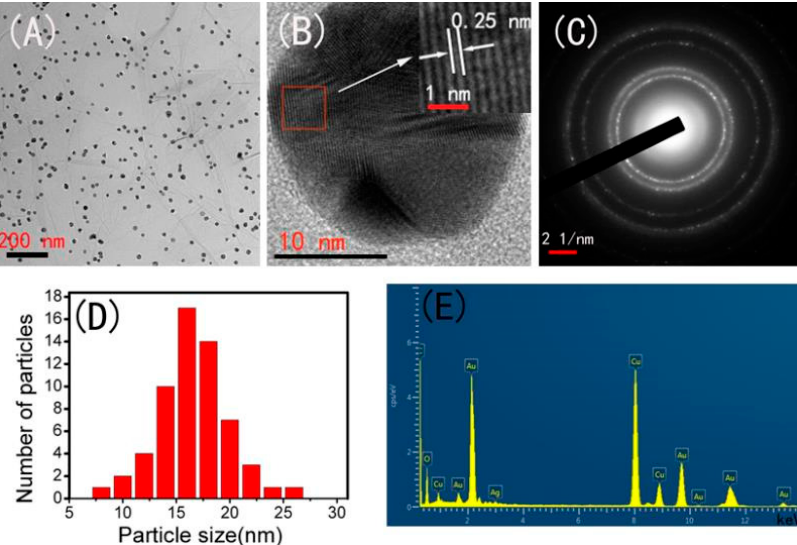
Figure 2. ( A ) Transmission electron microscopy (TEM) image; ( B ) HR-TEM image; ( C ) selected area electron diffraction (SAED) pattern; ( D ) the size distribution histogram; and ( E ) energy dispersive X-ray spectroscopy (EDS) spectrum of Ag-AuNPs/RGO.